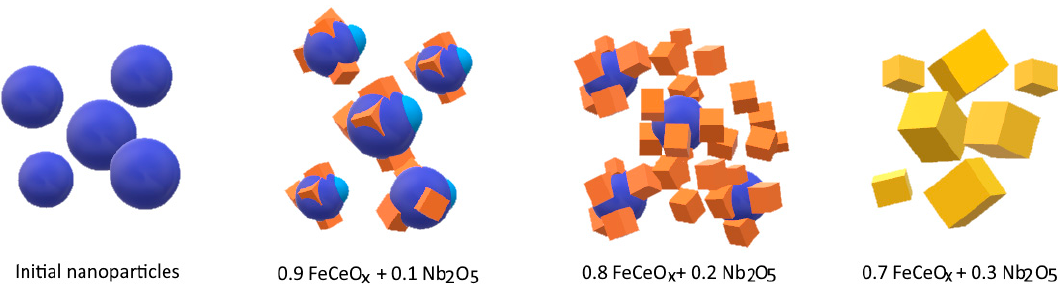
Figure 3. Schematic representation of the transformation of the geometry of the synthesized nanoparticles as a result of an increase in the concentration of the dopant Nb 2 O 5 .